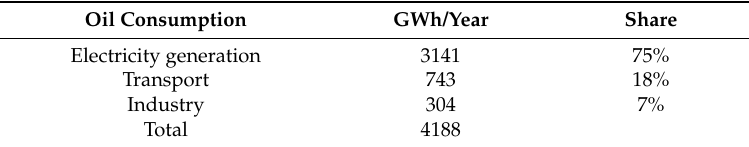
Table 1. Primary energy demand for the representative Caribbean island.